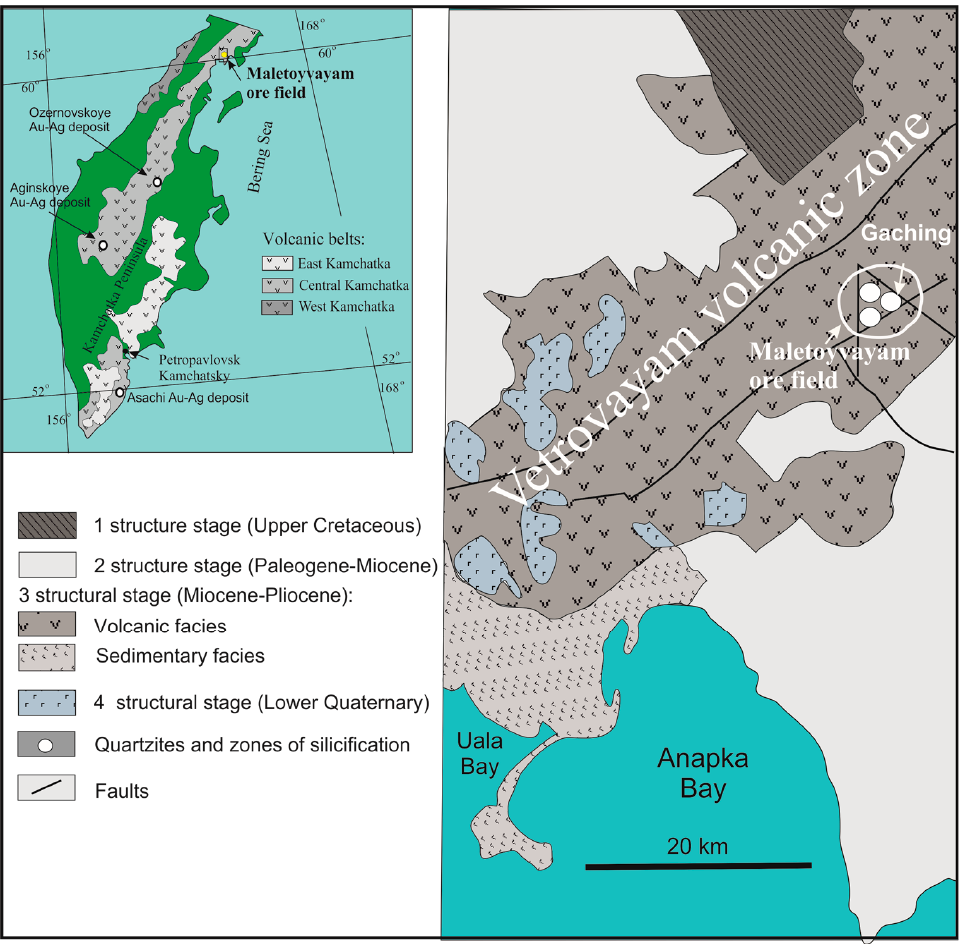
Figure 1. Volcanic belts of the Kamchatka Peninsula [15], the tectonic scheme of the Vetrovayam volcanic zone [16] and location of Maletovvayam ore field on the base [17] (reproduced with permission from reference [14]).